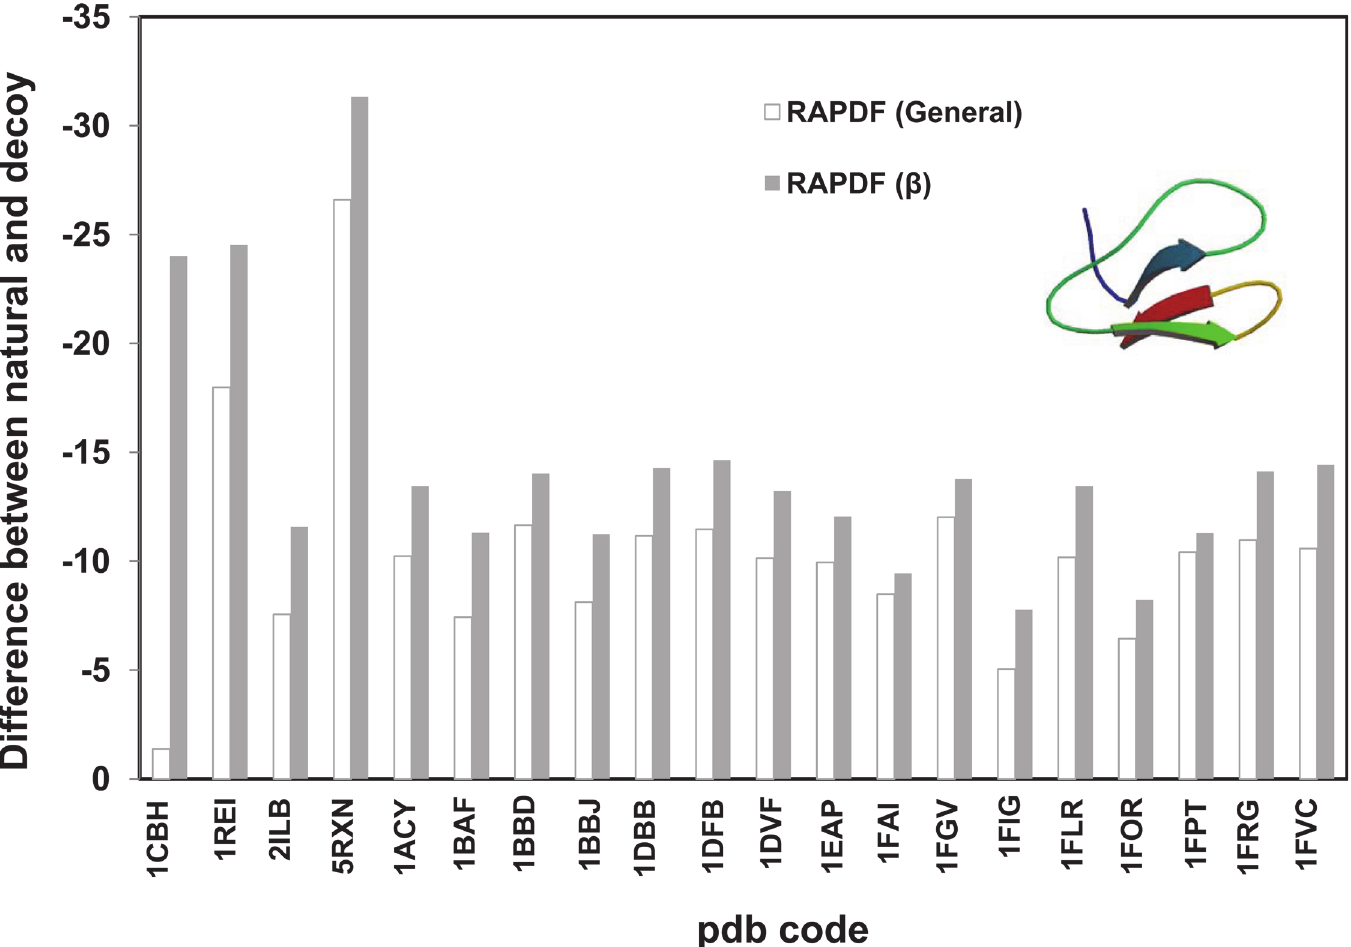
Fig 4. Evaluating the stability of β proteins using distance-dependant statistical potential based on β protein library (288 proteins). RAPDF ( β ) represents the statistical RAPDF scores calculated using the β - database. First 4 sets were single misfold decoy sets and the rest 16 sets were from multiple decoy sets with a representative decoy